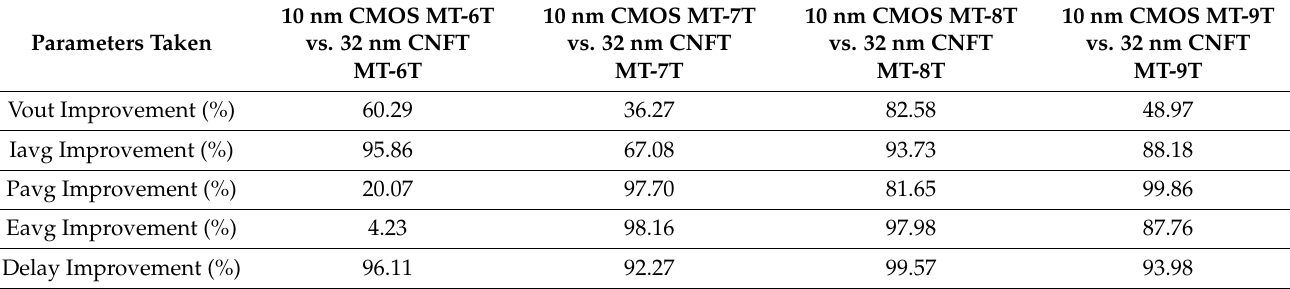
Table 13. Improvement of 32 nm CNFET MT-SRAM Cells over 10 nm CMOS MT-SRAM Cells.